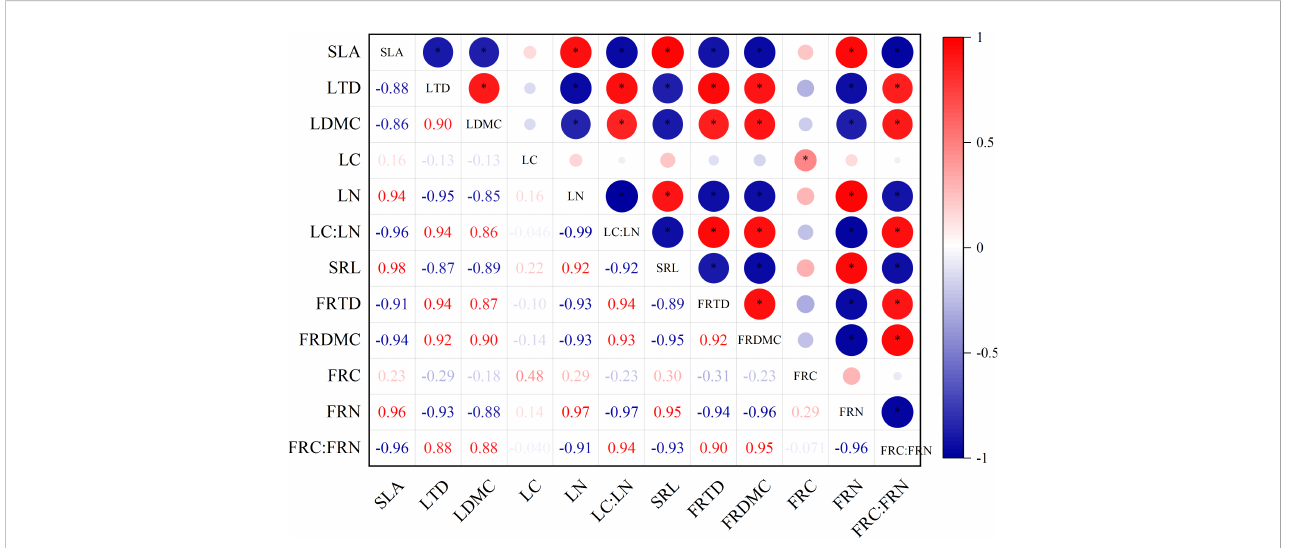
FIGURE 6 Correlations between leaves and fi ne roots. (All abbreviations are shown in (Figure 1).